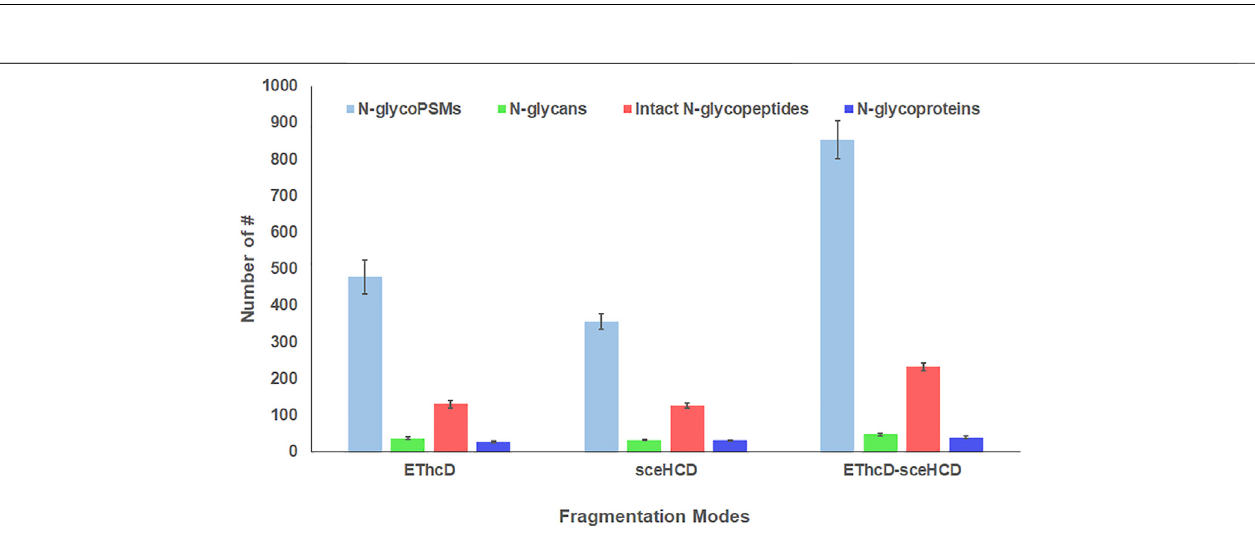
FIGURE 1 | Schematic representation of the work fl ow for human plasma LAP intact N-glycopeptide analysis using different dissociation methods (EThcD, sceHCD, and EThcD-sceHCD).